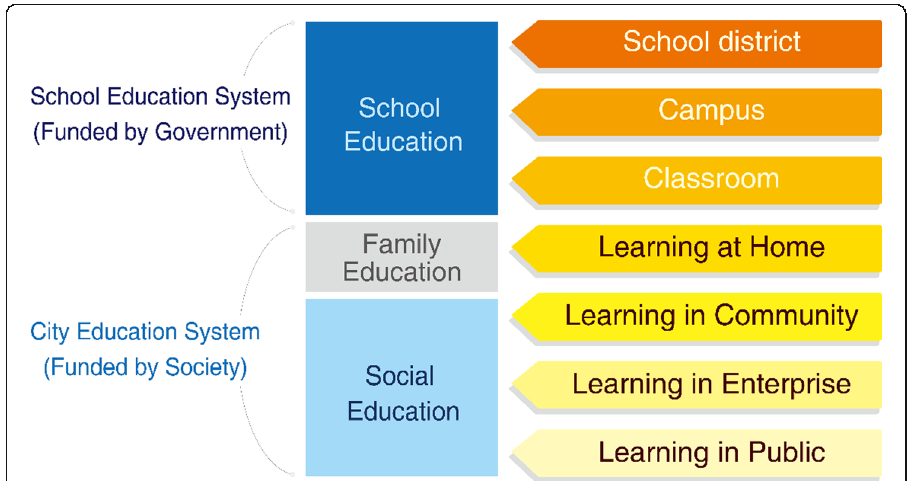
Fig. 1 Typical learning environments in a smart city. (adapted from Huang, R., Liu, D., Fan, L., Zhuang, R. & Fang, H. et al. (2015). White Paper: Smart Learning Environments in China 2015. Beijing, China: Smart Learning Institute, Beijing Normal